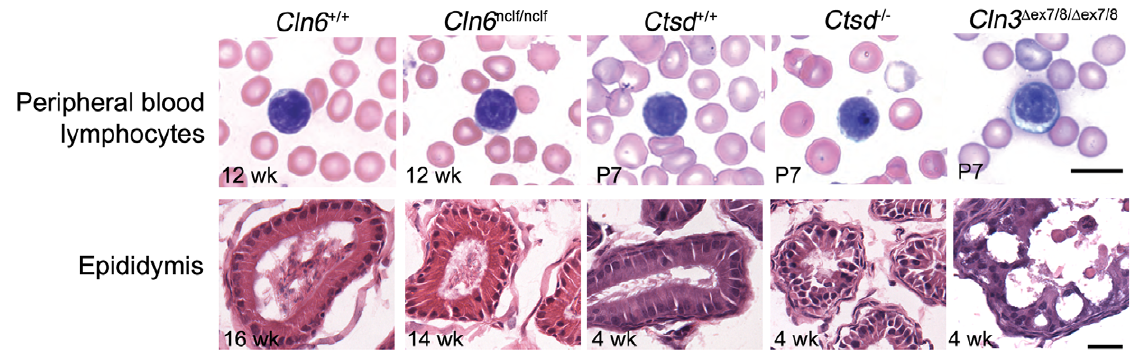
Figure 9. Cellular vacuolation is specific to CLN3 dysfunction. Representative images are shown of Wright-Giemsa stained peripheral blood smears and H&E-stained sections of male epididymis from mice representing three different forms of NCL. Ages of the mice at the time of sample collection are indicated. Note the obvious vacuolation of peripheral blood lymphocytes and clear cells of the epididymis in young homozygous Cln3 D ex7/8 mice ( Cln3 D ex7/8/ D ex7/8 ), shown at postnatal day 7 (P7) and 4 weeks of age (4 wk), respectively. Note the lack of abnormal vacuoles in Cln6 nclf/nclf and Ctsd 2 / 2 mice, which are models of variant late-infantile and congenital NCL, respectively. N=3 2 4 mice per genotype. Scale bars, top panels=10 m m; bottom panels=25 m